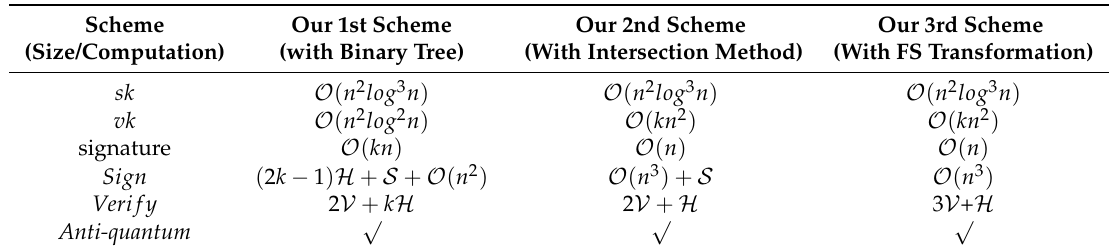
Table 1. Efficiency comparison of our